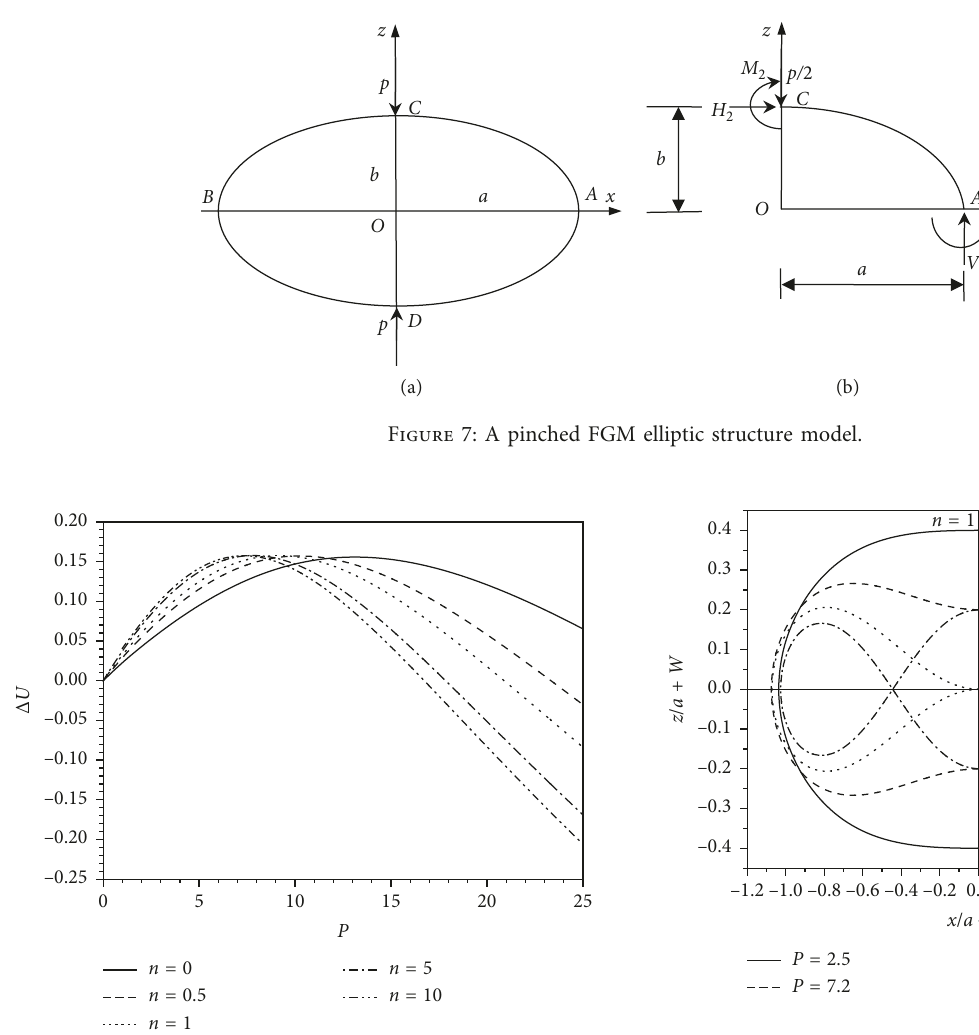
Figure 9: Equilibrium configurations of the elliptic curved beam for different values of P